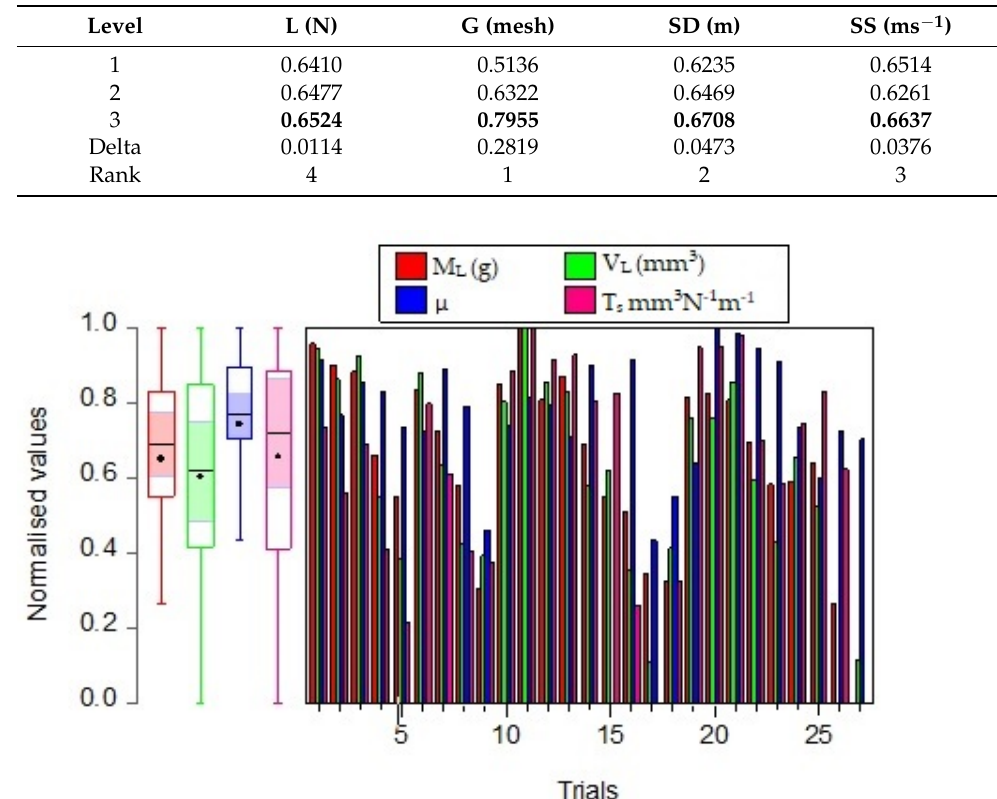
Figure 15. Reference sequence values for the L 27 (3 4 ) hybrid-Taguchi OA.